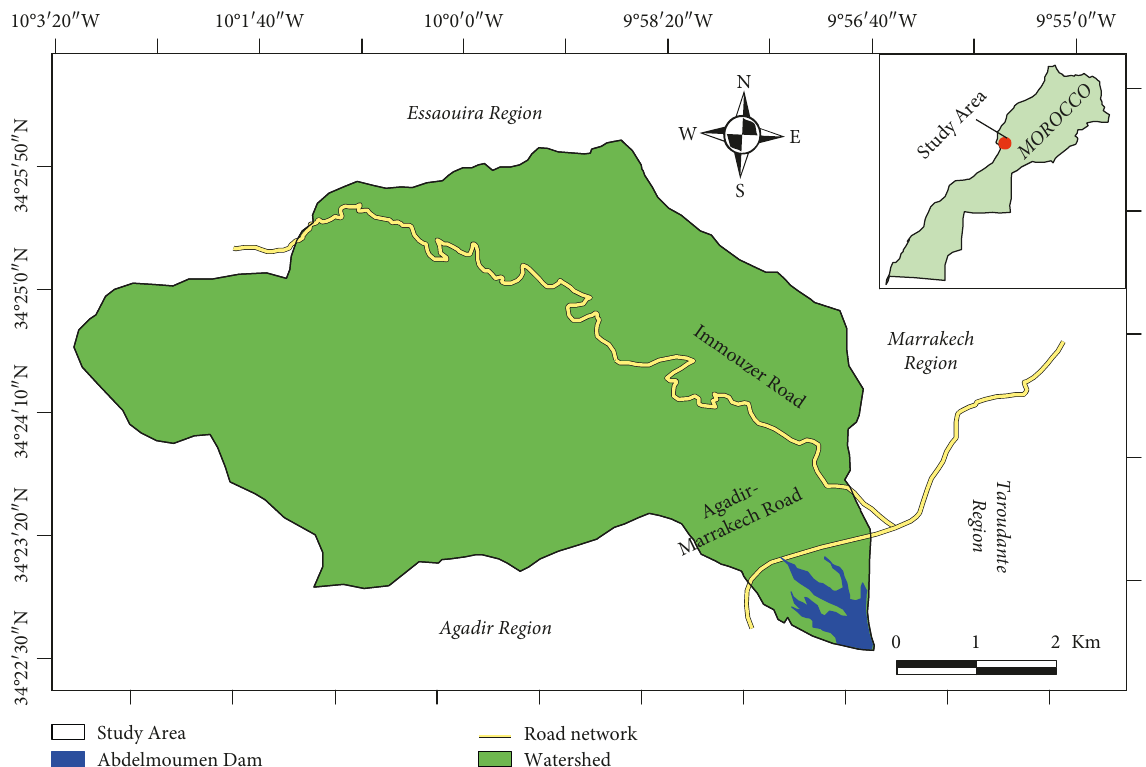
Figure 1: Situation map of the Bigoudine watershed region and the limits of the study area